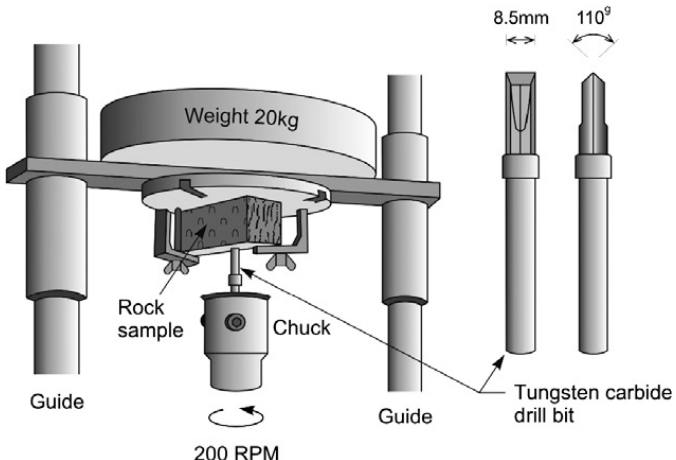
Figure 1. The Sievers’ miniature drill test [24].